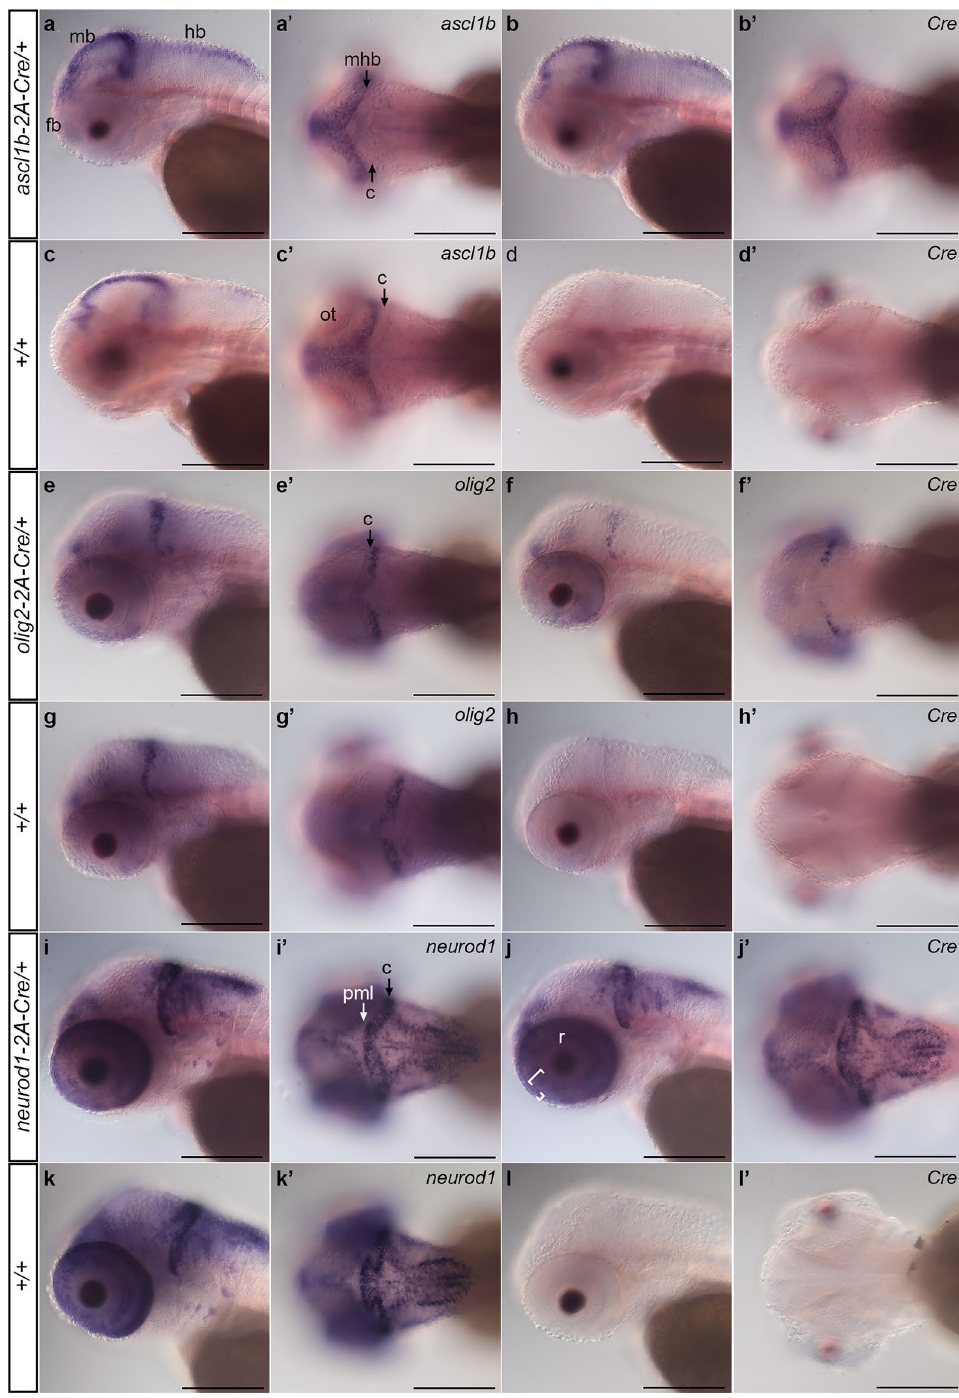
Figure 2. Expression of 2A-Cre integration alleles recapitulates ascl1b , olig2 , and neurod1 expression pattern. Whole mount in situ hybridization for endogenous genes and Cre was performed in 3 dpf larvae obtained from outcrossing ascl1b-2A- Cre/ +, olig2-2A-Cre/ +, and neurod1-2A-Cre/ + lines to wild type WIK. Sibling larvae from the same clutch were sorted into lens EGFP-positive and -negative groups before fixation. For each genotype and probe 3 individual larvae were photographed. ( a – d ) ascl1b and Cre expression in ascl1b-2A-Cre/ + larvae show similar patterns in the forebrain, and along the midbrain ventricle and midbrain-hindbrain border. ( e – g ) olig2 and Cre expression in olig2-2A-Cre/ + larvae were restricted to the forebrain, the posterior half of the cerebellum, and a subset of cells in the retina. ( i – k ) neurod1 and Cre expression in neurod1-2A-Cre/ + larvae were detected in the forebrain, adjacent to the midbrain and hindbrain ventricles and enriched in the cerebellum (( i ′ ), C black arrow), and in the retina inner (large bracket) and outer (small bracket) nuclear layers ( j ). neurod1 and Cre expression were not detected in the posterior peripheral midbrain layer (( i ′ ), PML white arrow). Cre expression was not detected in wild type +/+ sibling larvae ( d , h , l ). c cerebellum, fb forebrain, hb hindbrain, mb midbrain, mhb midbrain- hindbrain border, nt neural tube, ot optic tectum, pml peripheral midbrain layer, r retina. Scale bar 250